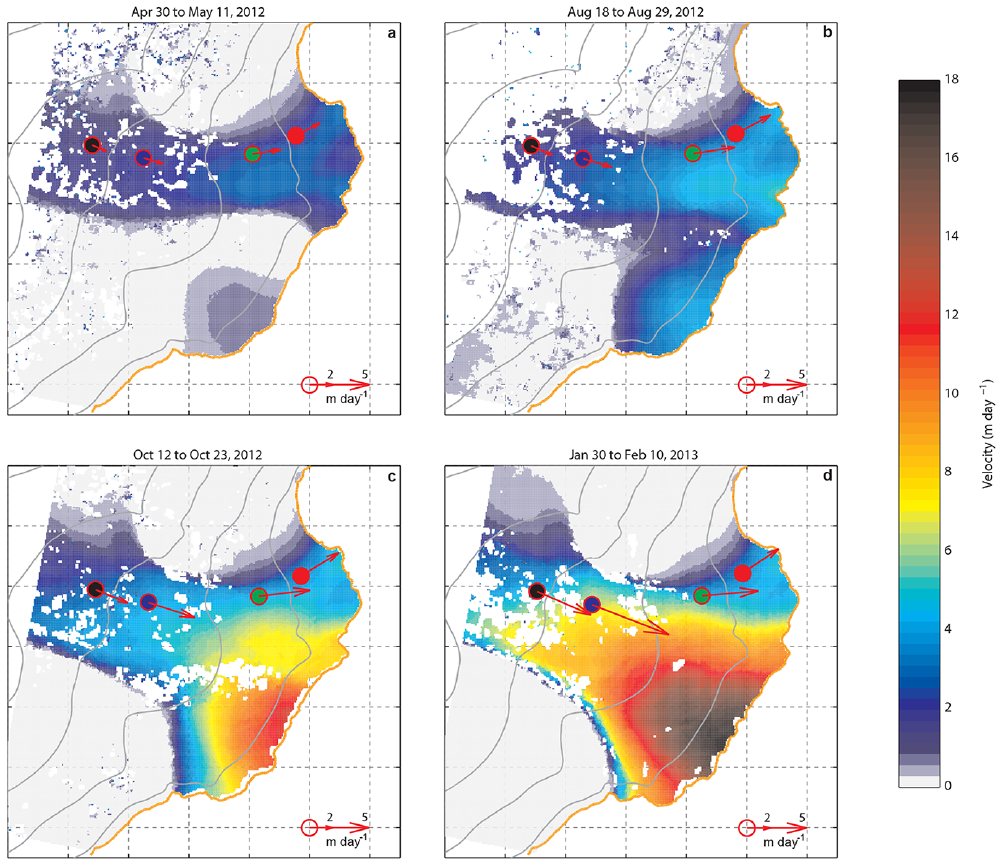
Figure 3. Surface velocity fields of Basin-3, Austfonna, derived from TerraSAR-X feature tracking: (a) April/May 2012, (b) August, (c) October, and (d) January/February 2013. Red circles represent mean position of GPS receivers over the particular repeat-pass period; fill colour according to colour coding of receivers in Fig. 2. The red arrows indicate associated GPS velocity vectors. Glacier elevation contours plotted in grey at 100m intervals; front position at time of repeat pass in